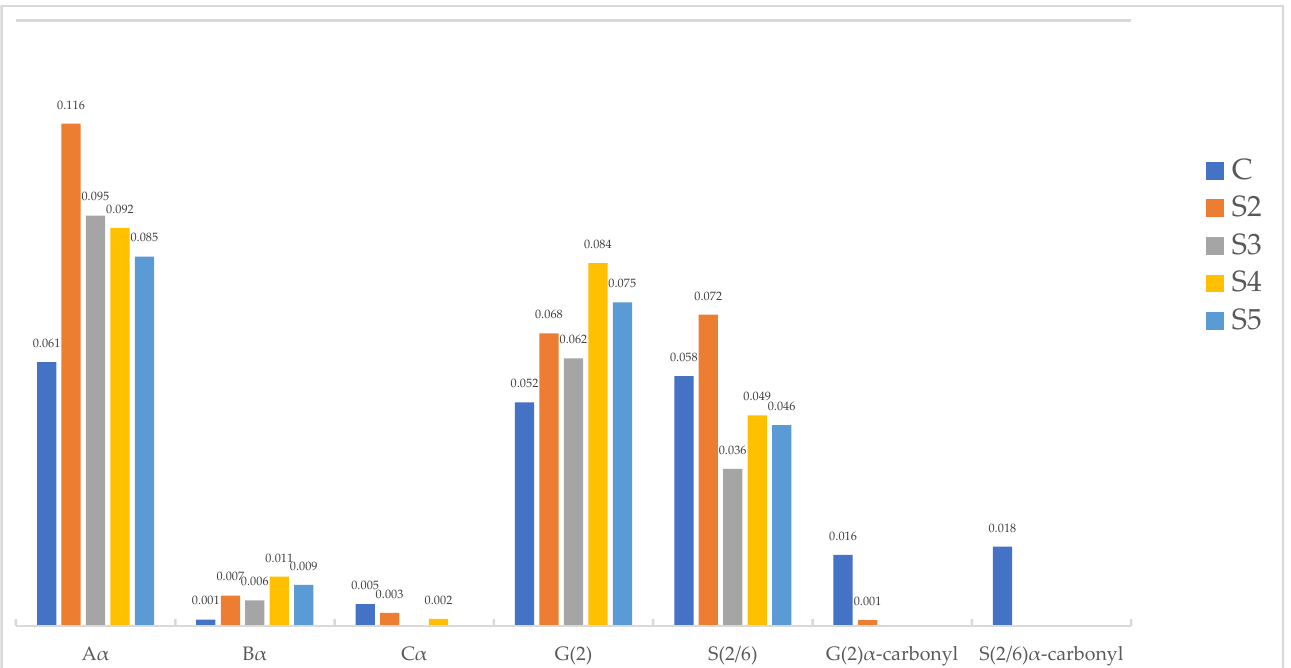
Figure 7. Bar chart summarizing the 2D NMR integrations of peaks from lignin subunits present in each spectrum of siloxane-treated wood ( S2 , S3 , S4 , and S5 ) with control degraded wood ( C ). The numbers above the bars indicate the actual value of the integral. All integrations are relative to the lignin methoxyl peak.